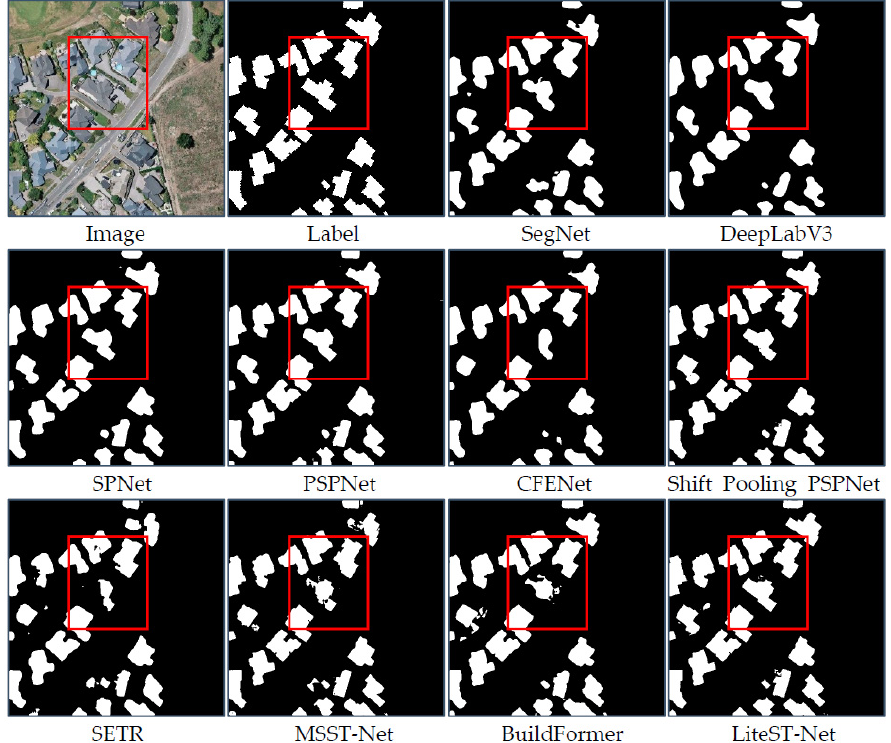
Figure 4. Prediction of classic networks for small buildings on the WHU building test dataset. The red box shows the predicted results of various models for the same small building.